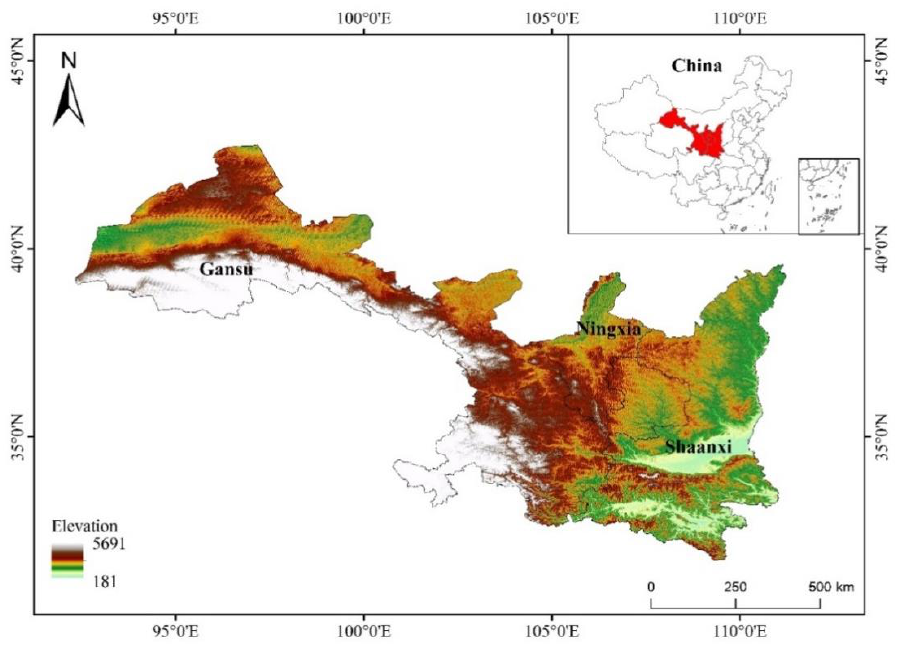
Figure 2. Map of the study area (source: ArcGIS 10).